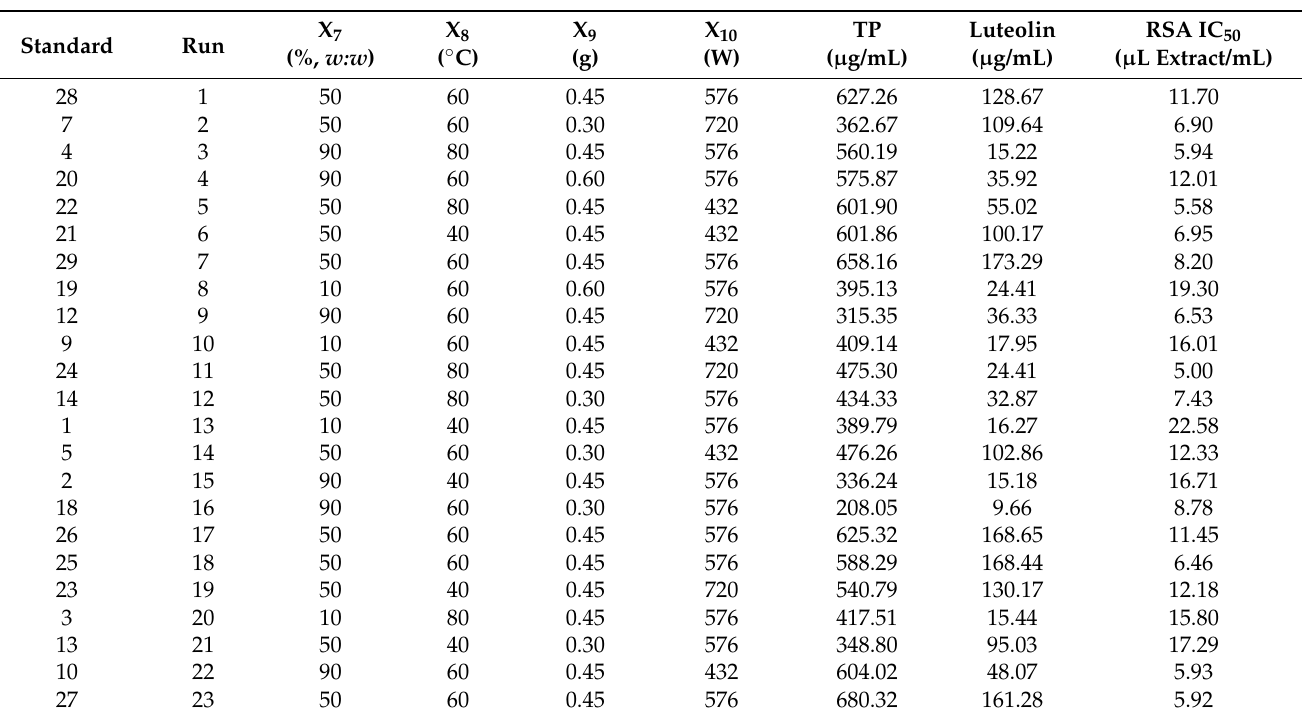
Table 2. Content of TP, luteolin, and radical scavenging activity of the extracts prepared according to the Box Behnken